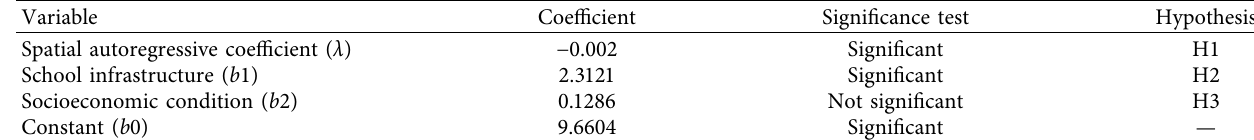
Table 6: The estimation results of the